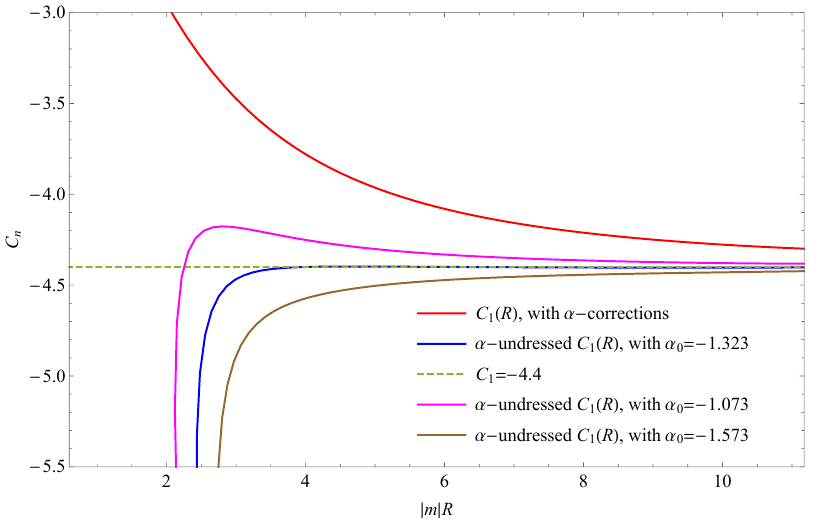
Figure 8 . Plots of TFFSA data for C 1 ( R ) (in red line), and the plots of (3.18) against ˜ R (TTbar- undressed C (0) ( R ) ), with few sample values of α 0 . The estimating value of α 0 can be read from the 1 blue line.